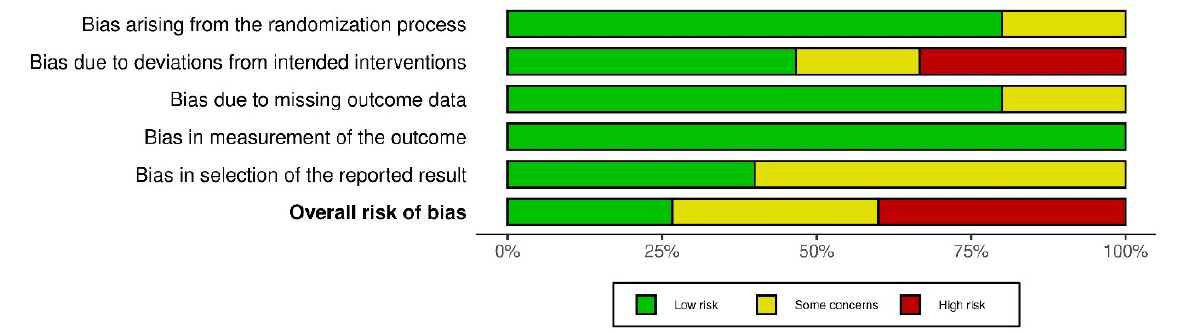
Figure 3. Summary of risk ‐ of ‐ bias assessment.